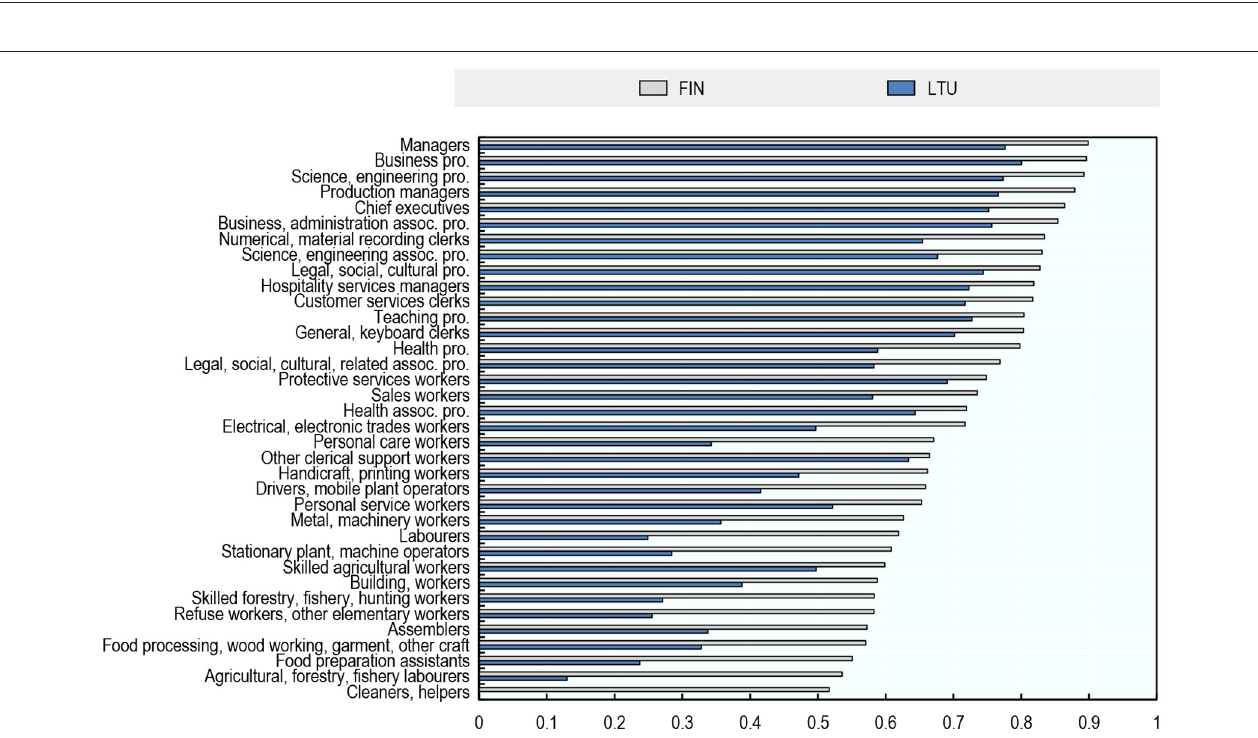
FIGURE 7 | The distribution of AI exposure across occupations is similar in Finland and Lithuania. Exposure to AI, 2012. Authors’ calculations using data from the Programme for the International Assessment of Adult Competencies (PIAAC) and Felten et al. (2019).